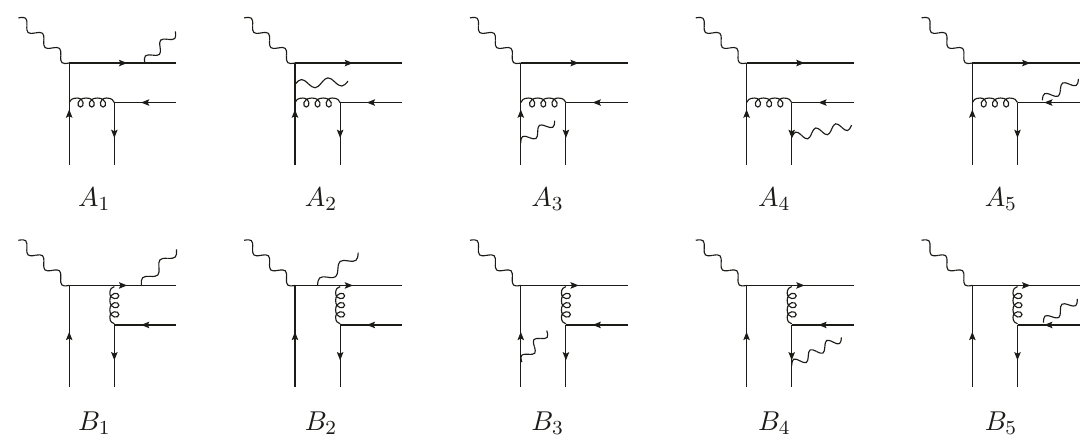
Figure 2 . Half of the Feynman diagrams contributing to the hard